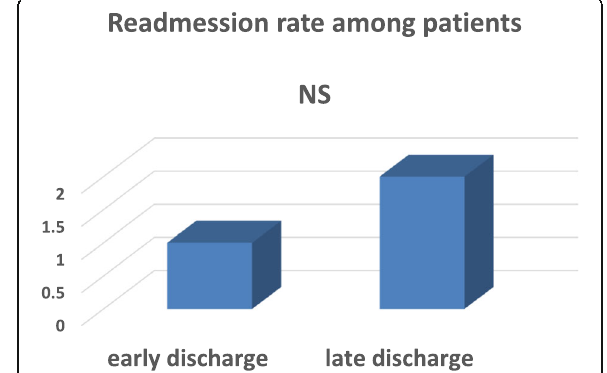
Fig. 4 Comparison of readmission of early and late discharged